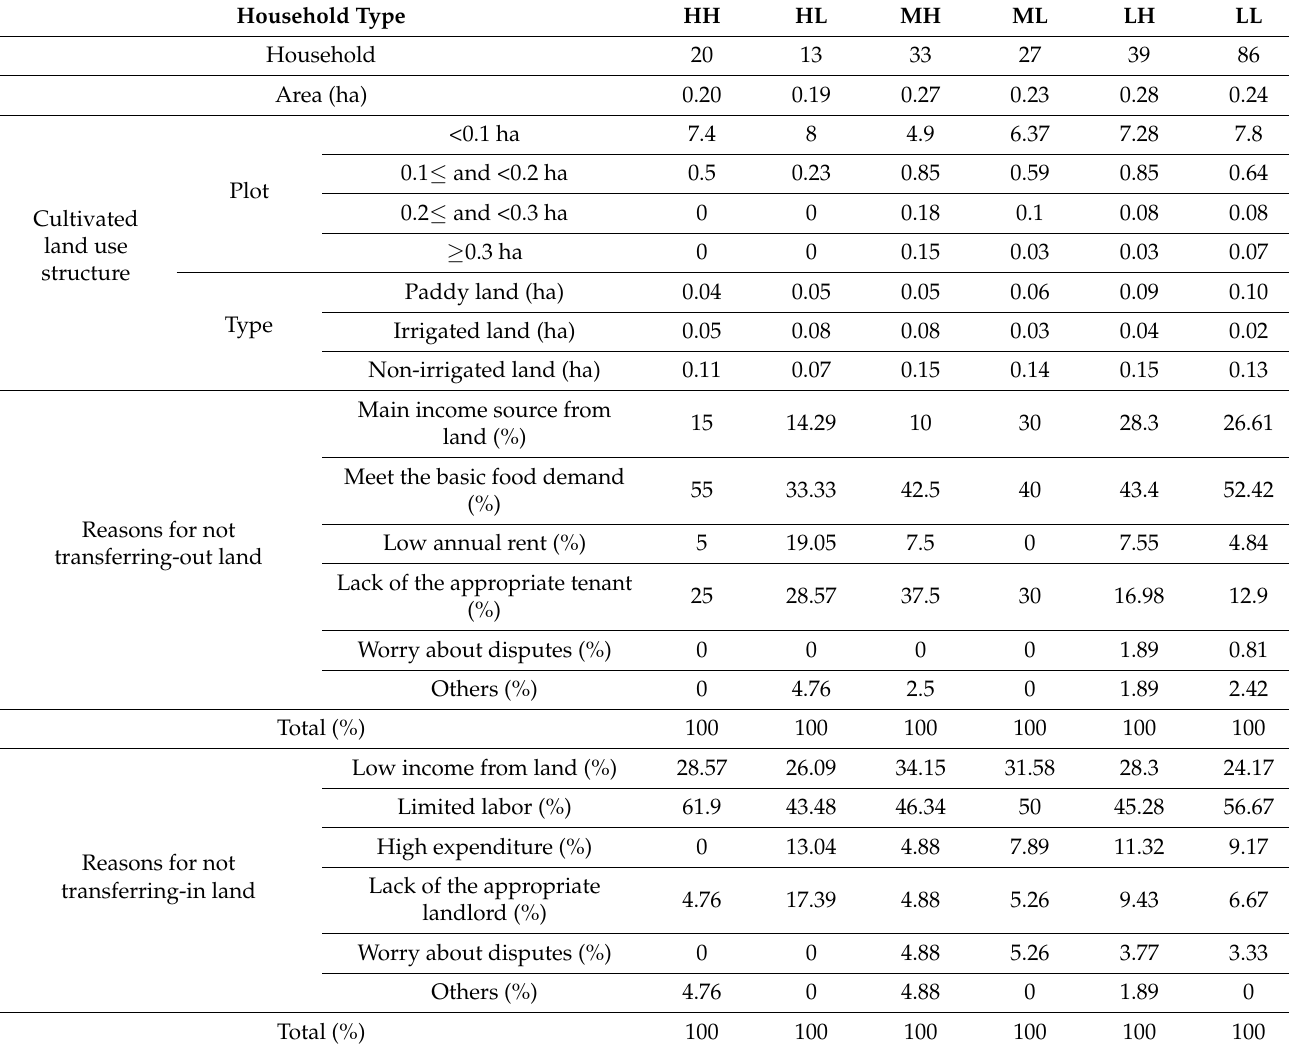
Table 11. Land self-cultivation